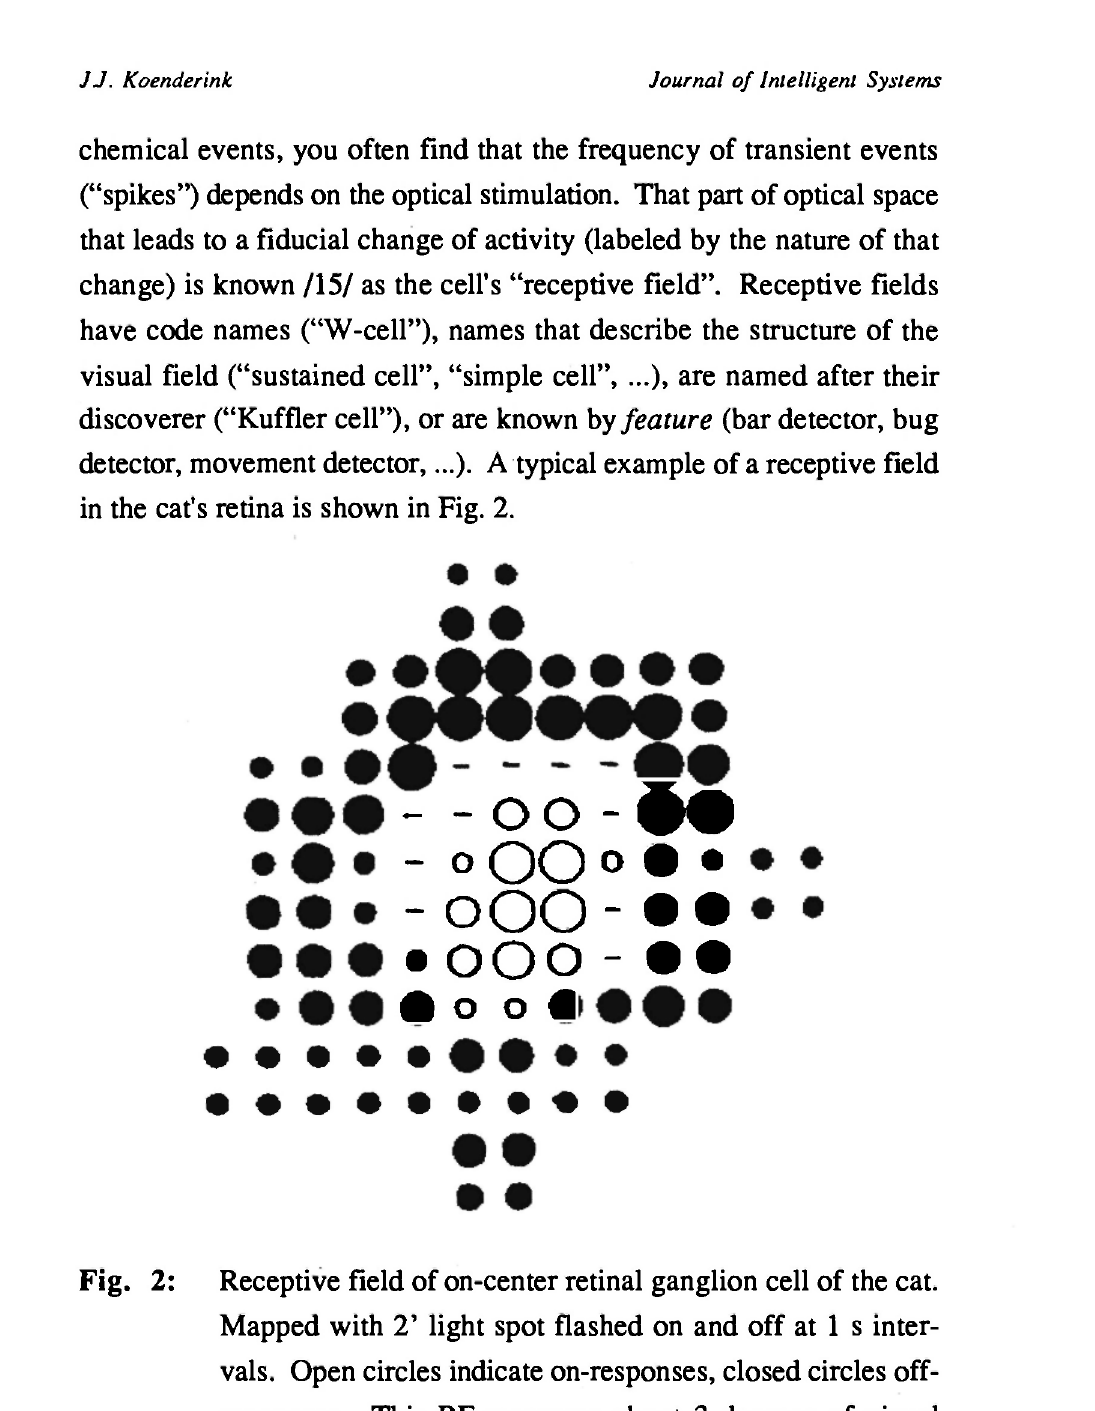
Fig. 2: Receptive field of on-center retinal ganglion cell of the cat. Mapped with 2' light spot flashed on and off at 1 s inter- vals. Open circles indicate on-responses, closed circles off- responses. This RF measures about 3 degrees of visual angle in diameter. (Slightly edited, after Rodieck and Stone